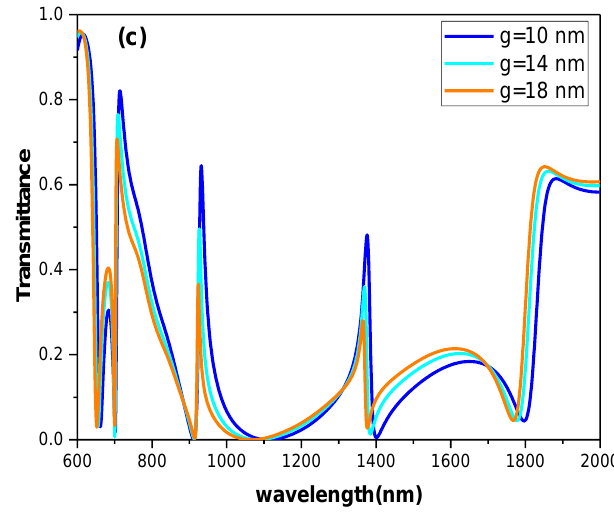
Figure 5. ( a ) The transmission spectra of the extended structure with different R0 from 315 nm to 345 nm. ( b ) The resonant wavelengths of Dip, NFR3, NFR4, NFR5 and FR with variable R0. ( c ) The transmission spectra of the extended structure with different g2 from 10 nm to 18 nm.